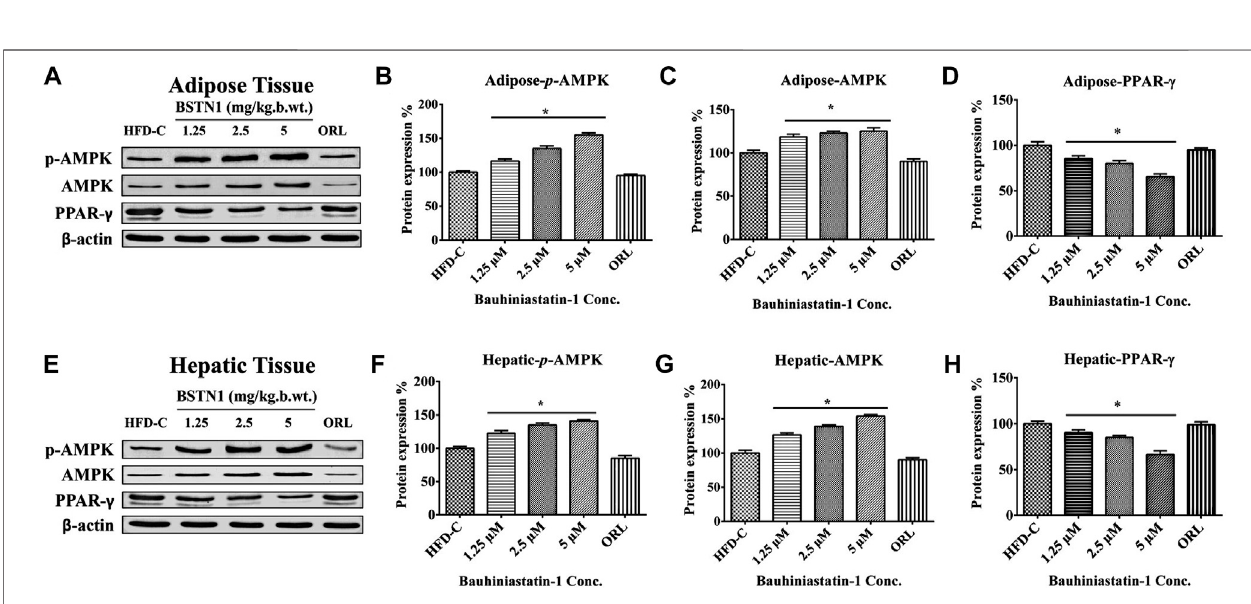
Frontiers in Pharmacology |